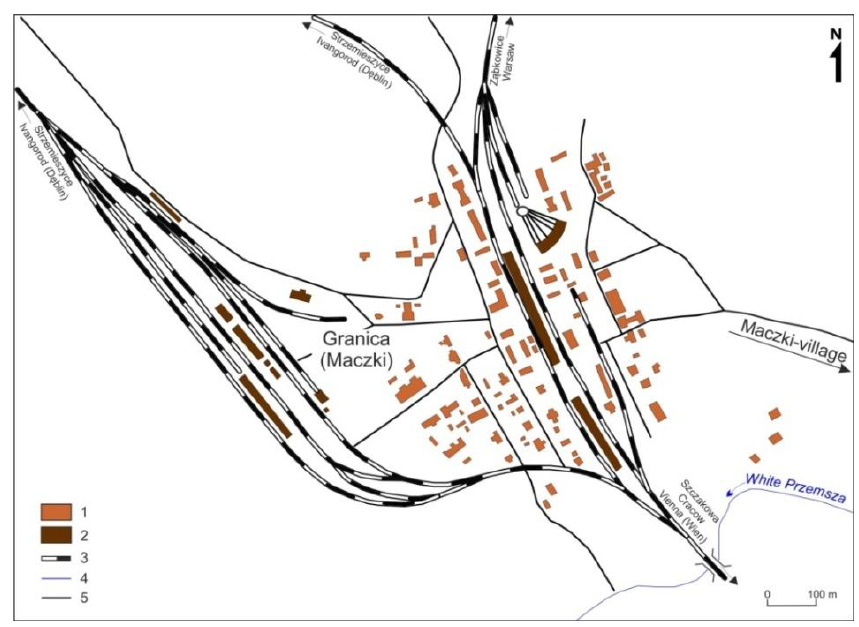
Fig. 6. Spatial arrangement of Granica (Maczki) in the late nineteenth century